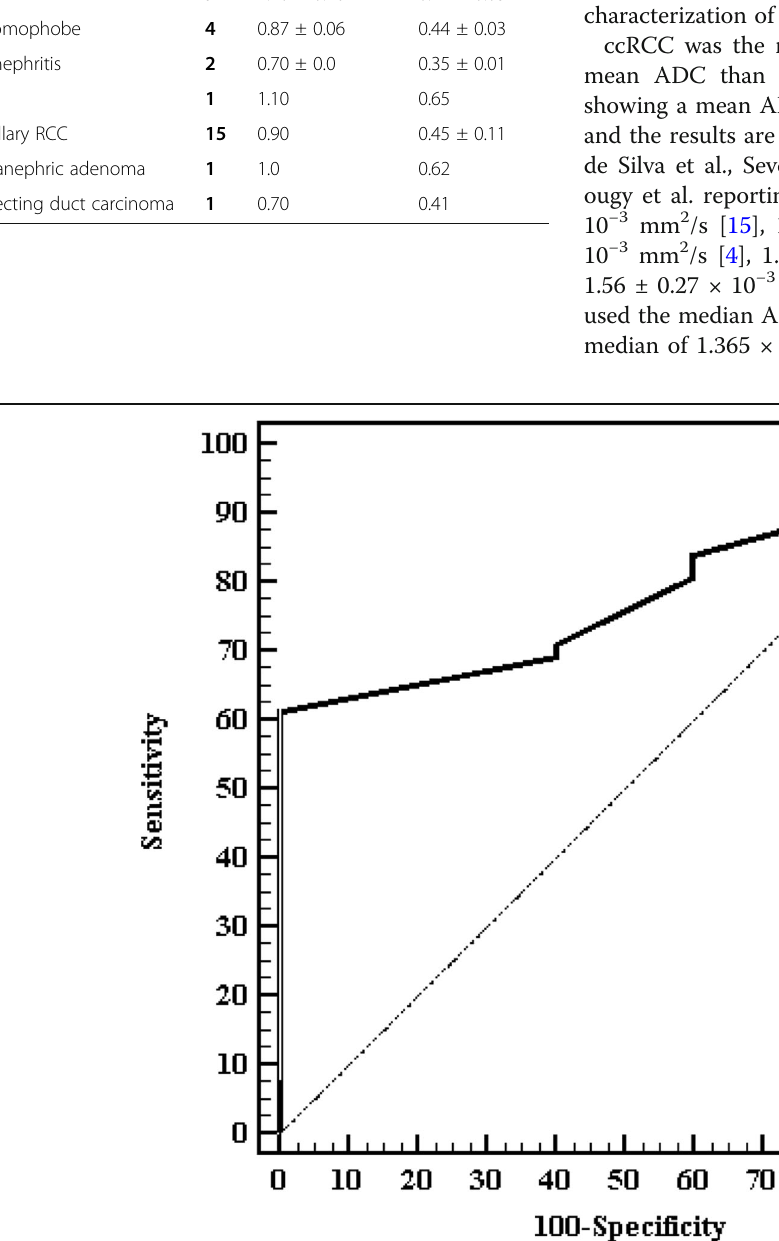
Multiple studies aiming at investigating different pa- rameters in a trial to differentiate those subtypes based on imaging were done. Finding a method to distinguish the lesion along with its extensions is important for the management, and as contrast-enhanced studies are not always feasible (either due to patient-related factors or technical difficulties as well as cost-related issues), our study aimed at studying the role of DWI/ADC as a tool in diagnosis and characterization, as well as comparing ADC value and ADC ratio and their roles in the characterization of the renal masses. ccRCC was the most common subtype with a higher mean ADC than other benign and malignant lesions showing a mean ADC value of 1.4 ± 0.19 × 10 − 3 mm 2 /s, and the results are consistent with those by Zhang et al., de Silva et al., Sevcenco et al., Serter et al., and el Ser-